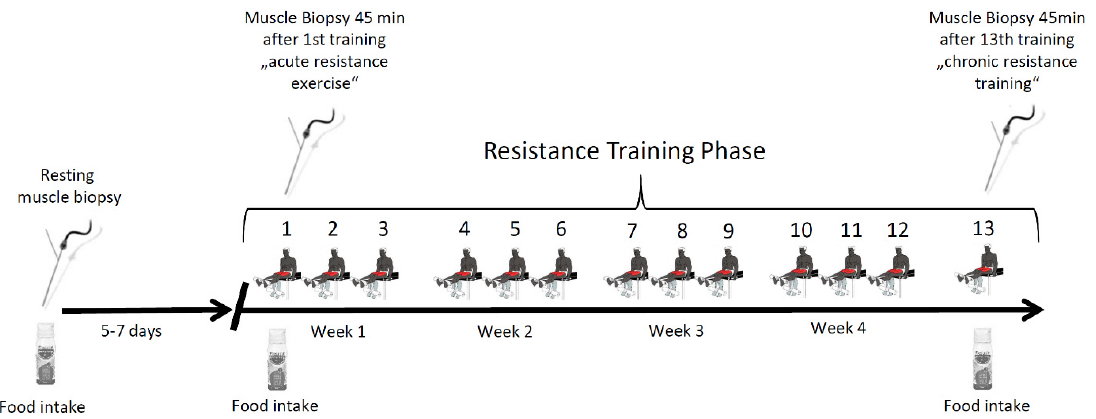
Figure 1. Study protocol. Schematic depiction of the study protocol. Subjects conducted 13 resistance exercise sessions over the time course of the study. Muscle biopsies were taken at rest as well as 45 min after the first and last training session in the fed state.